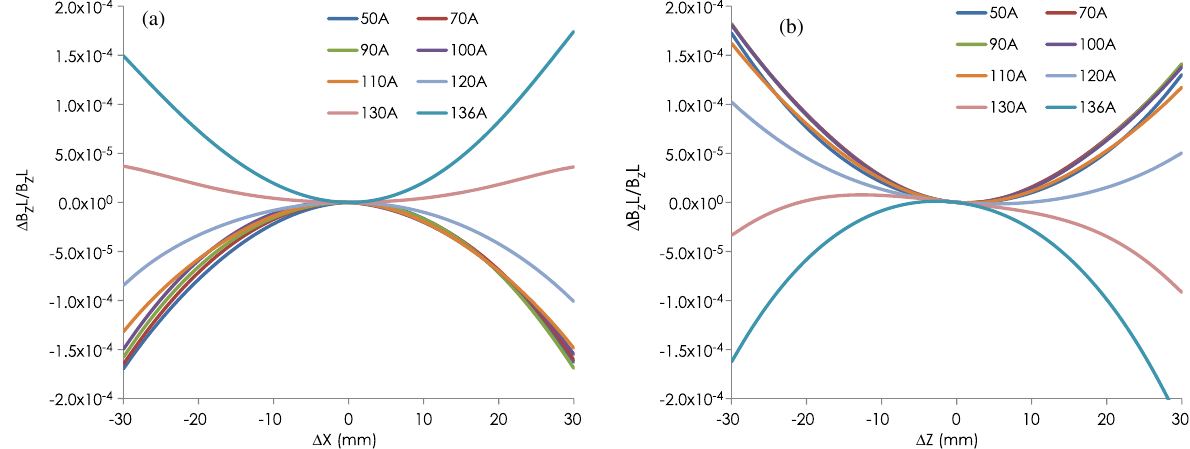
FIG. 12. Uniformity of BL products, (cid:1) B z L=B z L , of the dipole field for various coil currents of the dipole coil along (a) the X axis and (b) the Z axis, as determined by the three-dimensional field calculations.